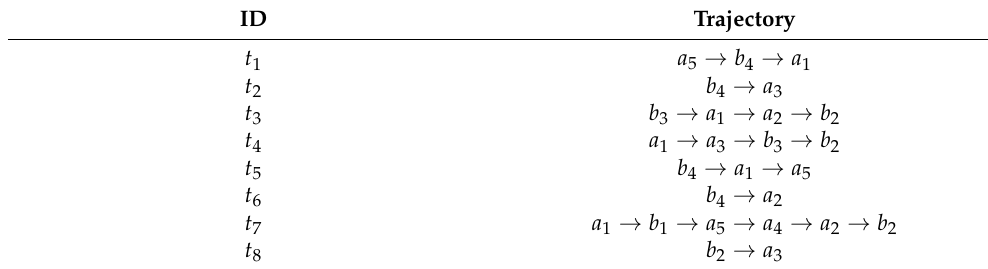
Table 1. An example of trajectory set T